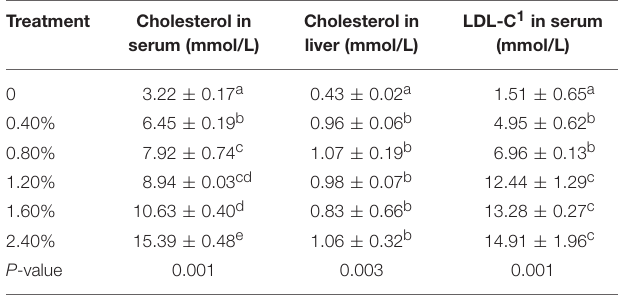
TABLE 4 | The contents of cholesterol and LDL-C in the serum and liver of Nile tilapia fed different cholesterol percentage diets for 8 weeks. Treatment Cholesterol in Cholesterol in LDL-C 1 in serum (mmol/L) liver (mmol/L)